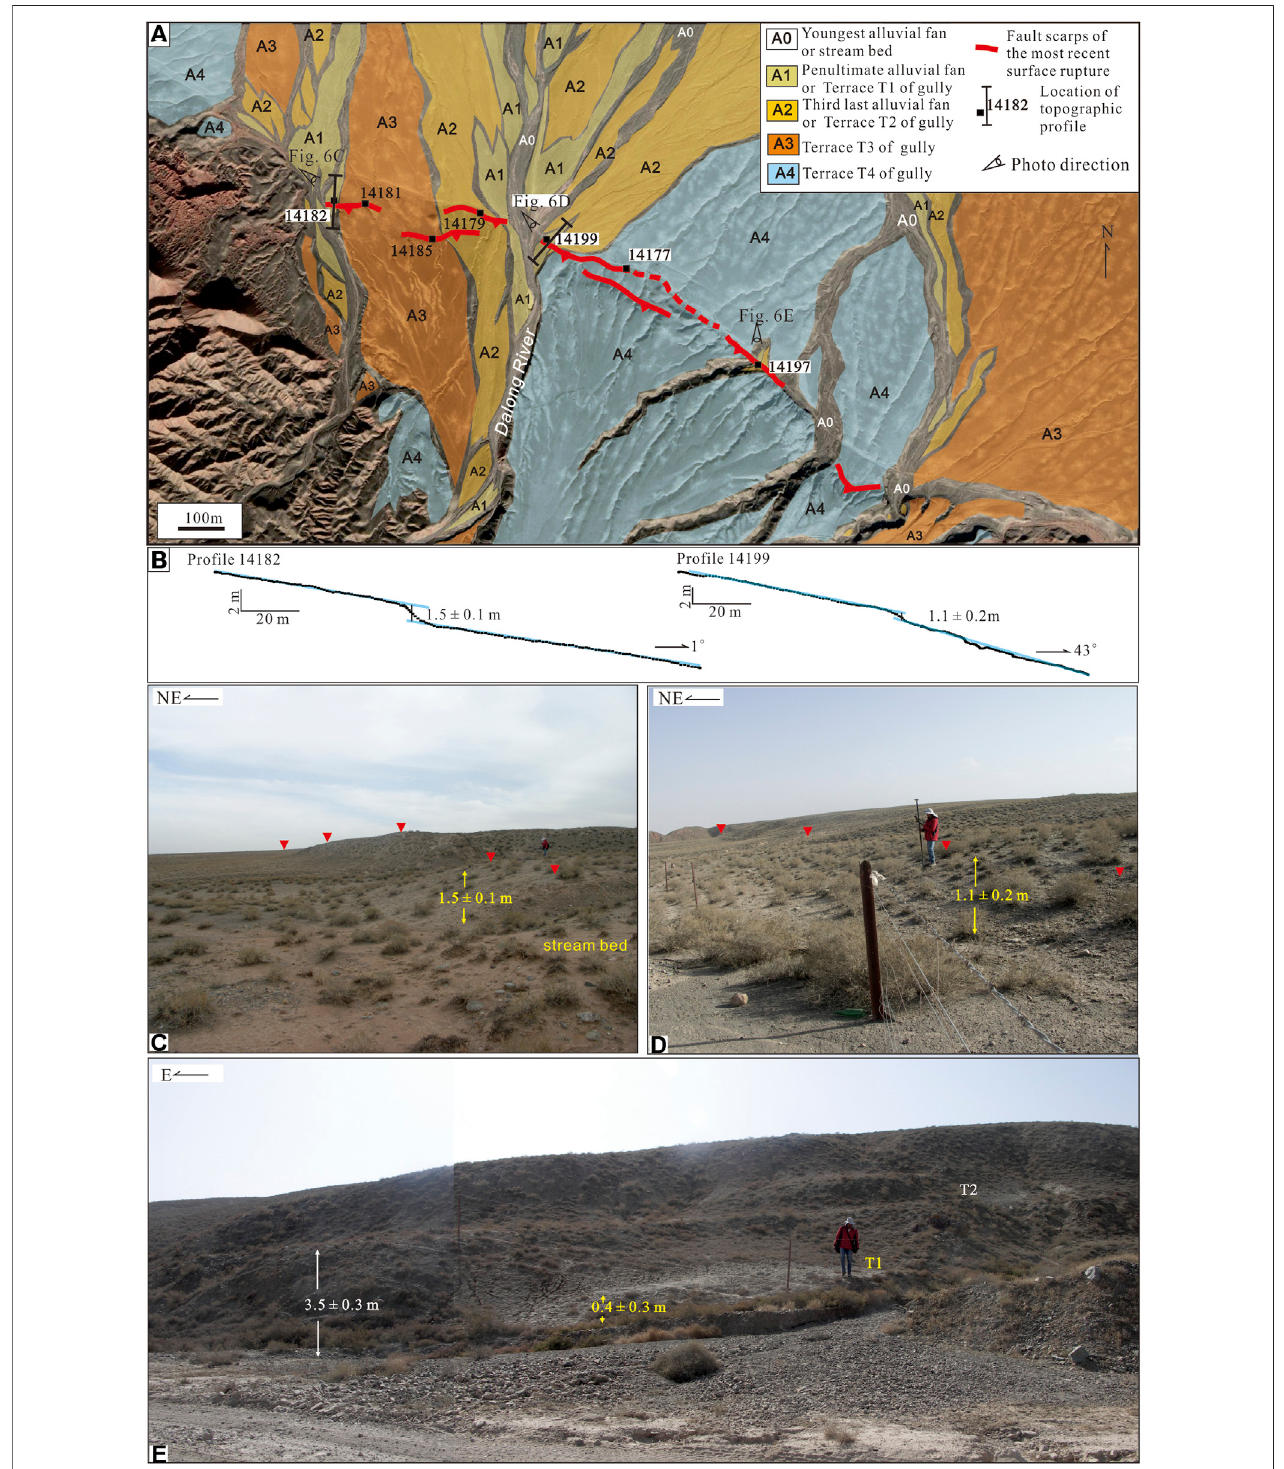
FIGURE 6 | Topographic features and photographs of the 1609 earthquake surface rupture on the Dalong River site. (A) Surface rupture map. (B) Topographic pro fi les across portions of 1609 rupture traces. (C) A simple fault scarp exists on T1 of a gully, covered by conglomeratic sand, and the vertical offset is 1.5 m. (D) The vertical offset of the fi rst terrace of the Dalong River is 1.1 m across a simple scarp with low amounts of loess covering it. (E) Fault scarps are present on the terraces of ephemeral gullies on T3 of the Dalong River.